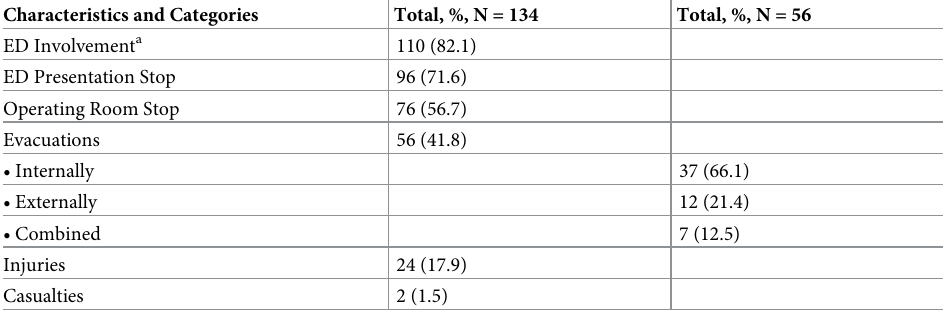
Table 3. Departmental effects, evacuation locations and injuries of IHCDs occurring in Dutch hospitals, 2000 to 2020. Characteristics and